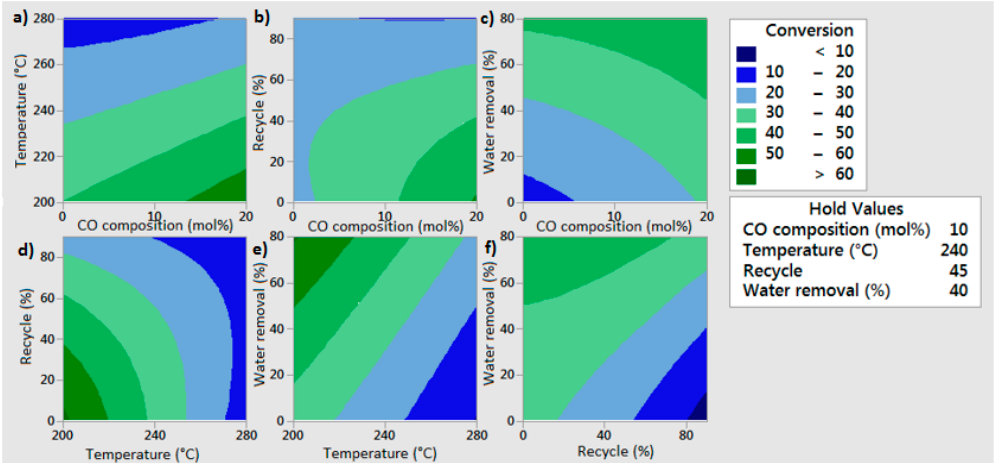
Figure 8. Surface plots of carbon conversion obtained by CCD analysis: ( a ) carbon conversion as function of temperature and CO composition in the feed; ( b ) carbon conversion as function of recycle and CO composition in the feed; ( c ) carbon conversion as function of water removal and CO composition in the feed; ( d ) carbon conversion as function of recycle and temperature; ( e ) carbon conversion as function of water removal and temperature; ( f ) carbon conversion as function of water removal and recycle.